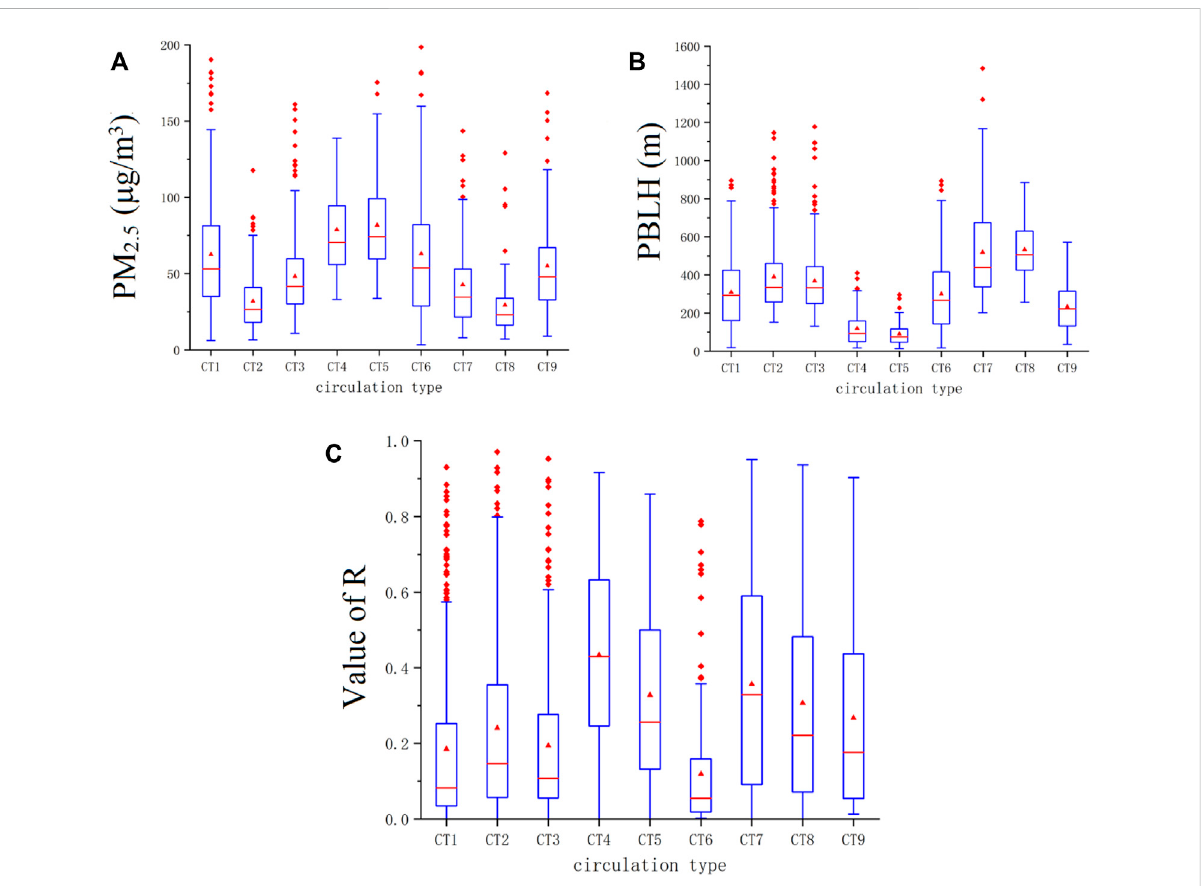
FIGURE 7 (A) ConcentrationdistributionofPM 2.5 , (B) PBLHdistribution,and (C) distributionoftherecirculationindex,R,asafunctionofthenineCTsinthe CZT